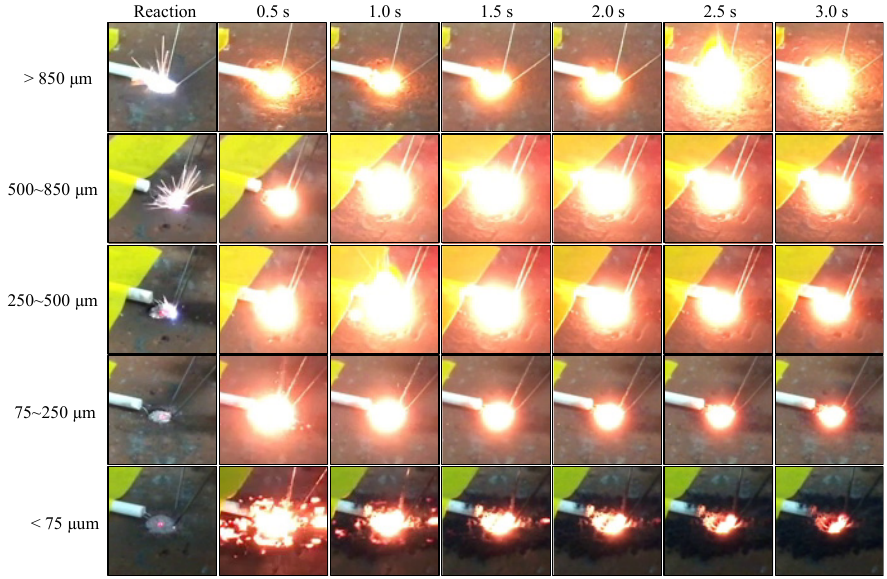
Figure 8. The exothermic reaction process recorded by the digital camera up to 3.0 s at an interval of 0.5 s.